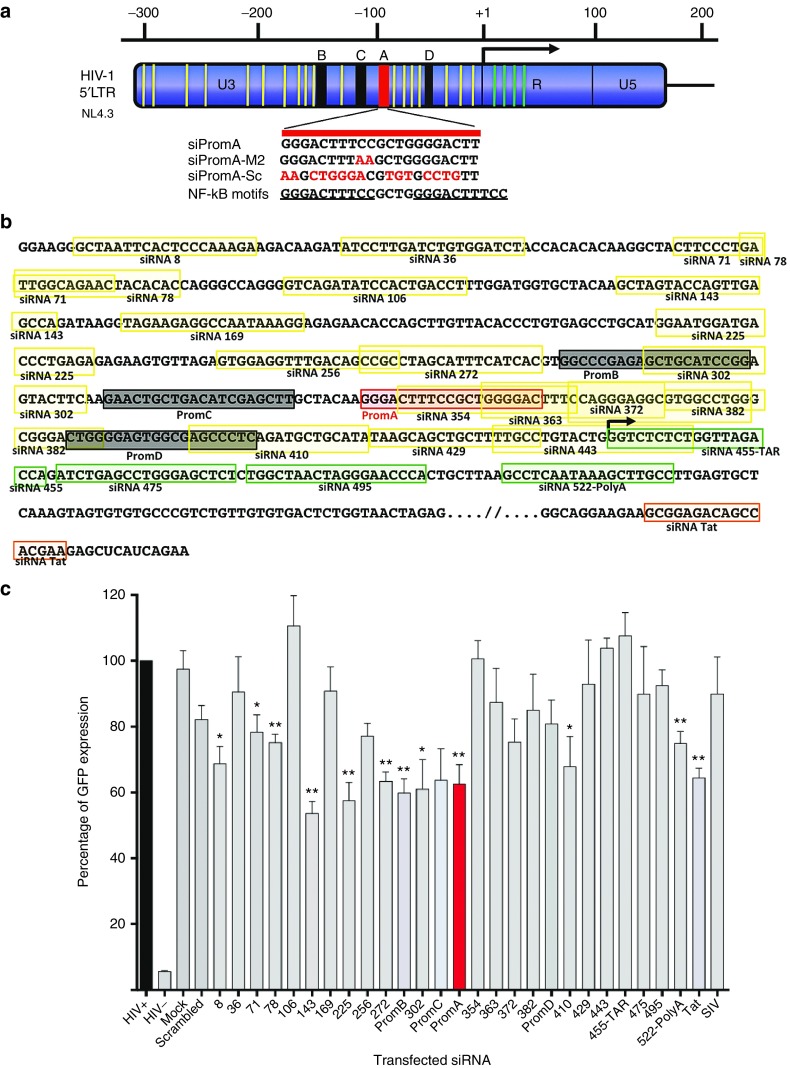
Candidate TGS inducing siRNAs targeting the HIV-1 5′LTR region. (a) Panel of siRNAs designed to target the HIV-1 5′LTR. Relative locations of candidate siRNAs are highlighted in yellow. Positions of previously reported siRNA, of which PromA (shown in red) targeting the NF-κB motifs is the most potent suppressor of HIV-1, while PromB, PromC, and PromD are shown in black. Candidate siRNAs designed to target the R region are shown in green. Sequence specificity controls, siPromA-M2 and siPromA-Sc, contain mismatched base pairs to siPromA. (b) Sequences of all siRNAs targeting the HIV-1 5′LTR region and part of the Tat exon. Bolded siRNA sequences boxed in yellow target the U3 region, while bolded siRNA sequence boxed in green and orange target the R region and Tat exon, respectively. PromA (bolded and boxed red), PromB, PromC, and PromD (bolded and boxed black) are shown for comparison. Nucleotide sequence shown is from HIV-1NL4.3. (c) Flow cytometry analysis of pseudotyped HIV-1 GFP expression in 293T cells transfected with a panel of candidate siRNAs targeting the HIV-1 5′LTR region. GFP expression was measured 48 hours posttransfection of siRNA. Data shown is mean ± SD from three independent experiments. *P ≤ 0.02, **P ≤ 0.008. The effect of the previously identified lead siRNA candidate for suppressing HIV-1 by TGS, PromA, is shown in red. Statistical comparisons were made between the HIV-1 GFP-pseudotyped positive control culture (black) and candidate siRNA-transfected cultures.